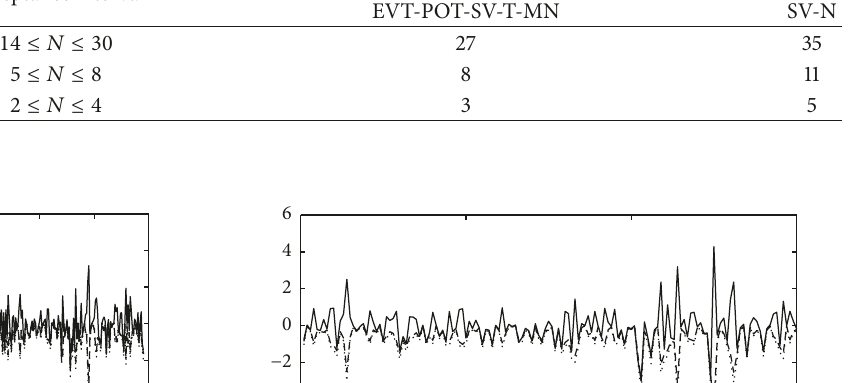
Table 6: The test of the number of failures of the return risk under different distribution assumptions at 𝑇 = 445. Confidence level